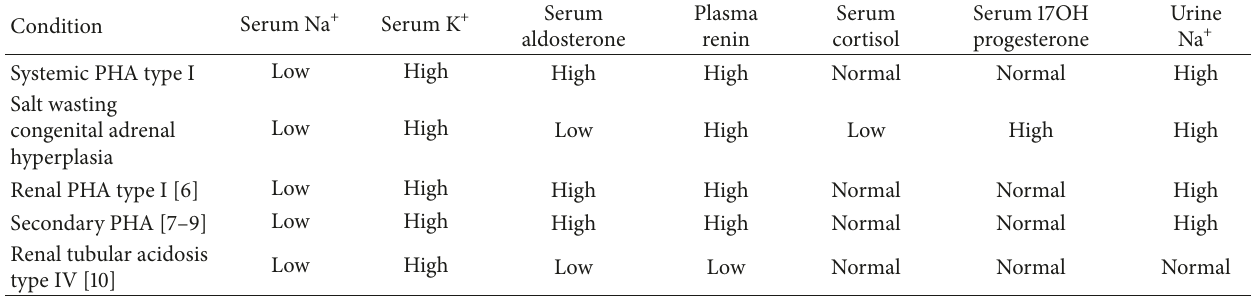
Table 1: Biochemical characteristics of the conditions included in the differential diagnosis for systemic pseudohypoaldosteronism type I.